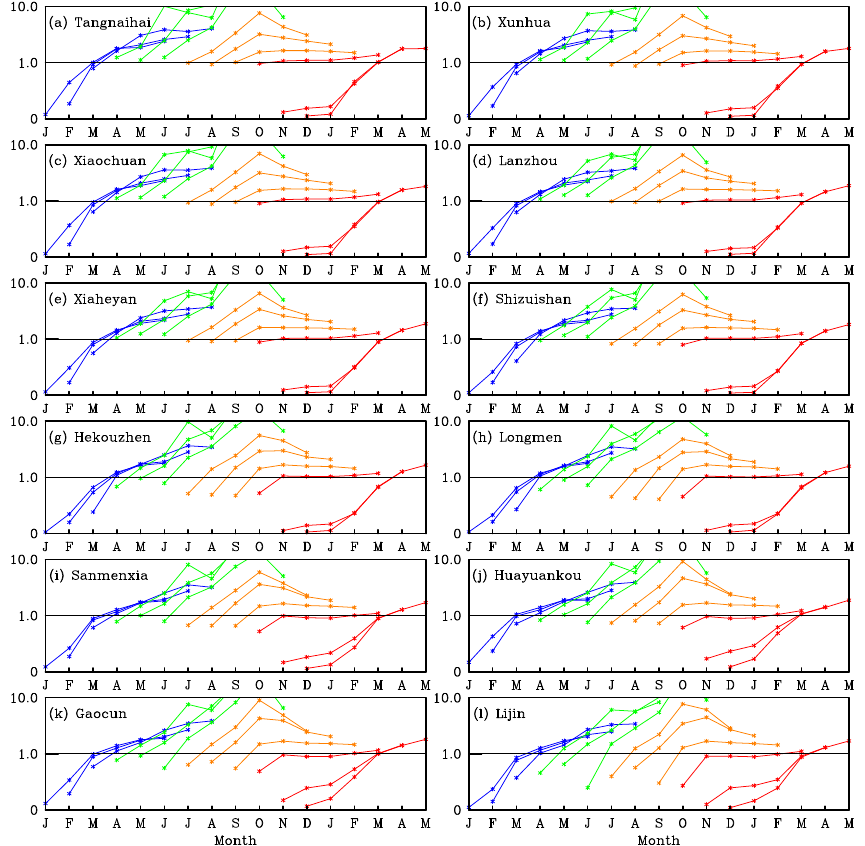
Figure 5. The root mean square error (RMSE) ratio (RMSE ESP /RMSE revESP ) as a function of start month and lead time at 12 hydrological gauges. The RMSE is calculated between the streamflow from a continuous simulation (with accurate initial condition and meteorological forcing) and that from the ESP or revESP